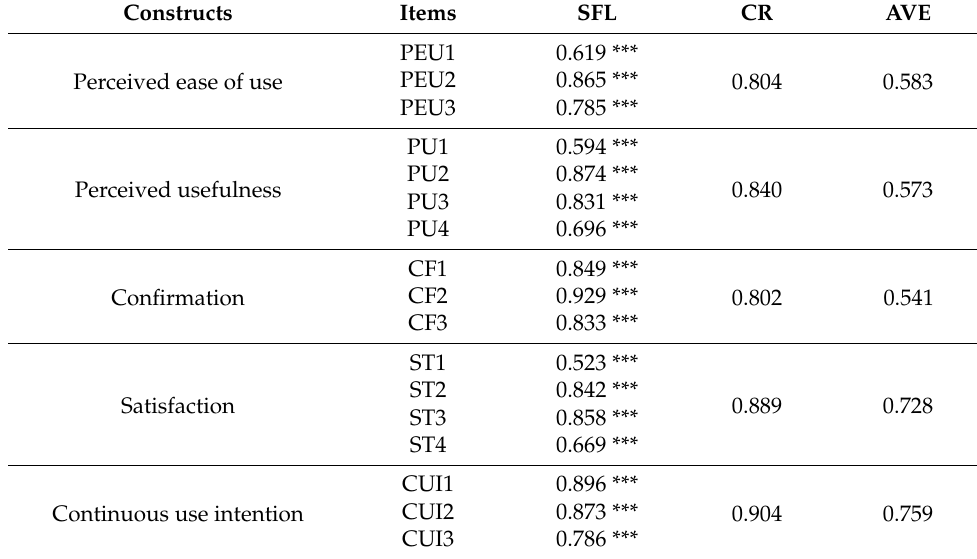
Table 4. Convergent validity test.